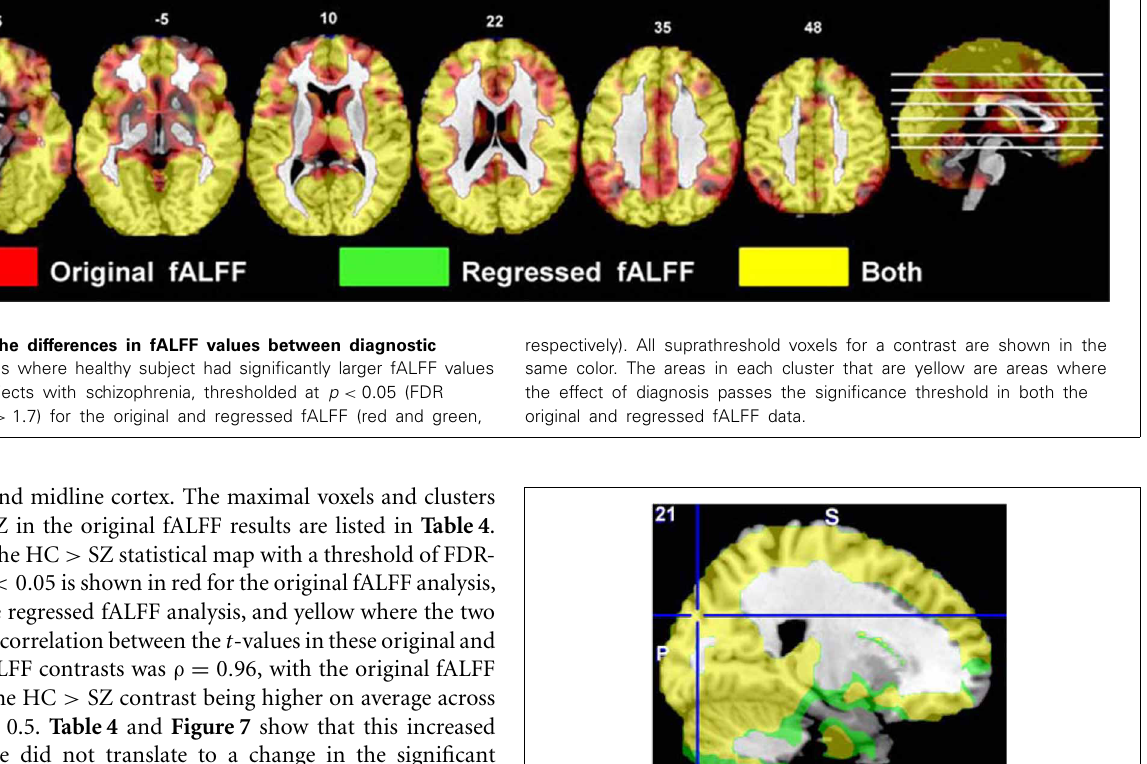
FIGURE 8 | The original fALFF mega-analysis Cohen’s d image for HC > SZ (in red) and the meta-analysis weighted Cohen’s d image (in green) overlain on a template brain. Both analyses are thresholded at d = 0 . 3 (moderate effect size); areas in yellow indicate both analyses passed the threshold. The cross hair is at (21, − 84, 30) the area of maximal significance in the original fALFF mega-analysis for HC >